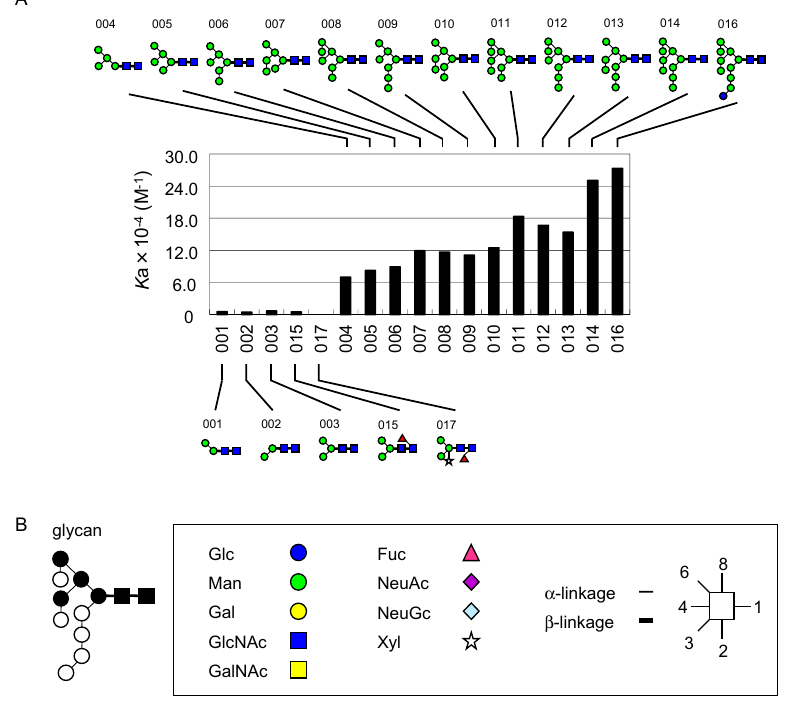
Figure 5. Featured specificity of UDA for high-mannose-type glycans. Bar graph representation for affinity constant ( K a ) in relation to the number of mannose residues ( A ); Bound and unbound (or weakly bound) glycan structures are shown at the top and bottom of the graph, respectively. Schematic drawings of a high-mannose structure, where essential and non-essential mannose residues are shown in closed and open circles, respectively ( B ). For carbohydrate structures using symbols, see explanation in the box below as in Figure 3.